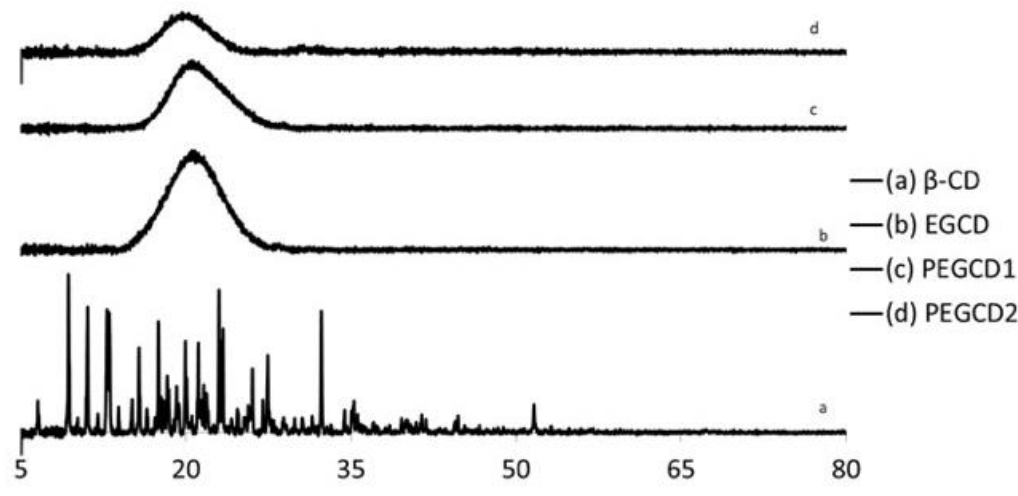
Figure 4. X-ray di ff raction (XRD) spectra of β -CD, EGCD, PEGCD1 and Figure 4. X-ray diffraction (XRD) spectra of β -CD, EGCD, PEGCD1 and PEGCD2.